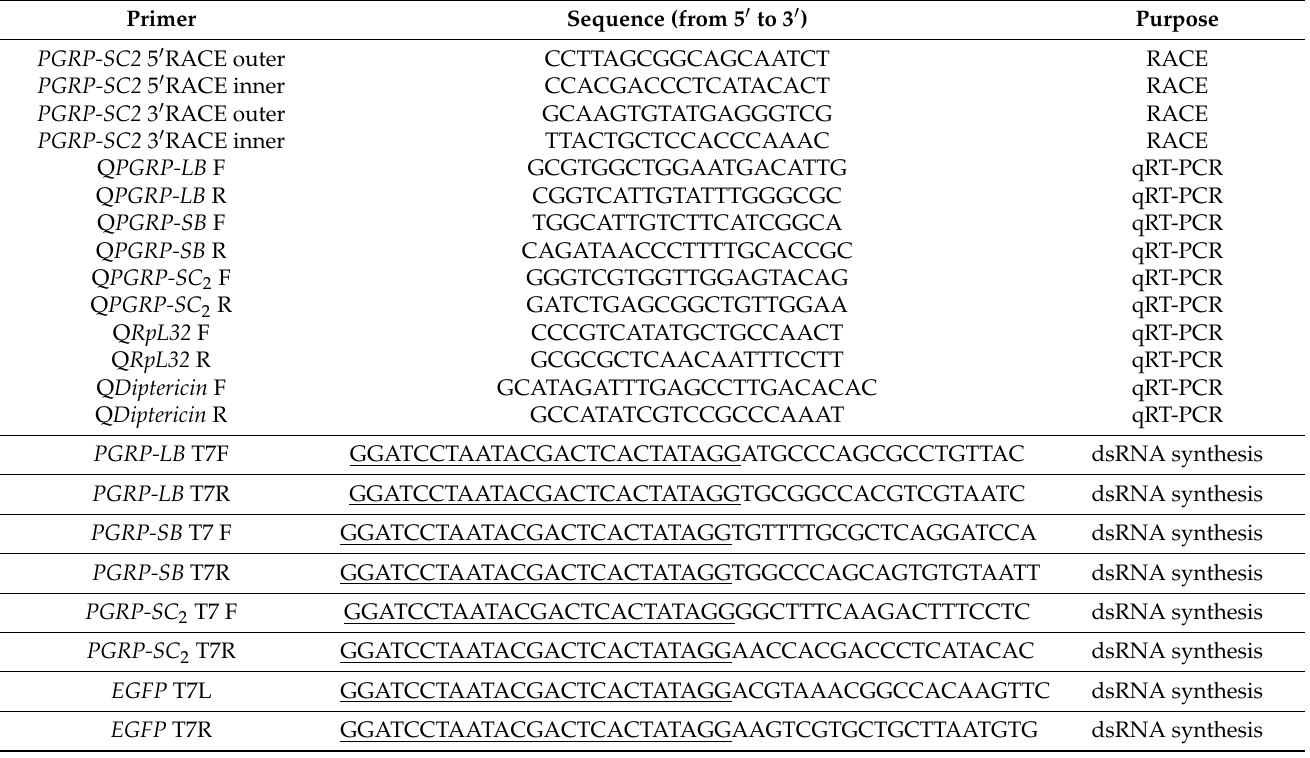
Table 1. Primers used in RT-PCR and